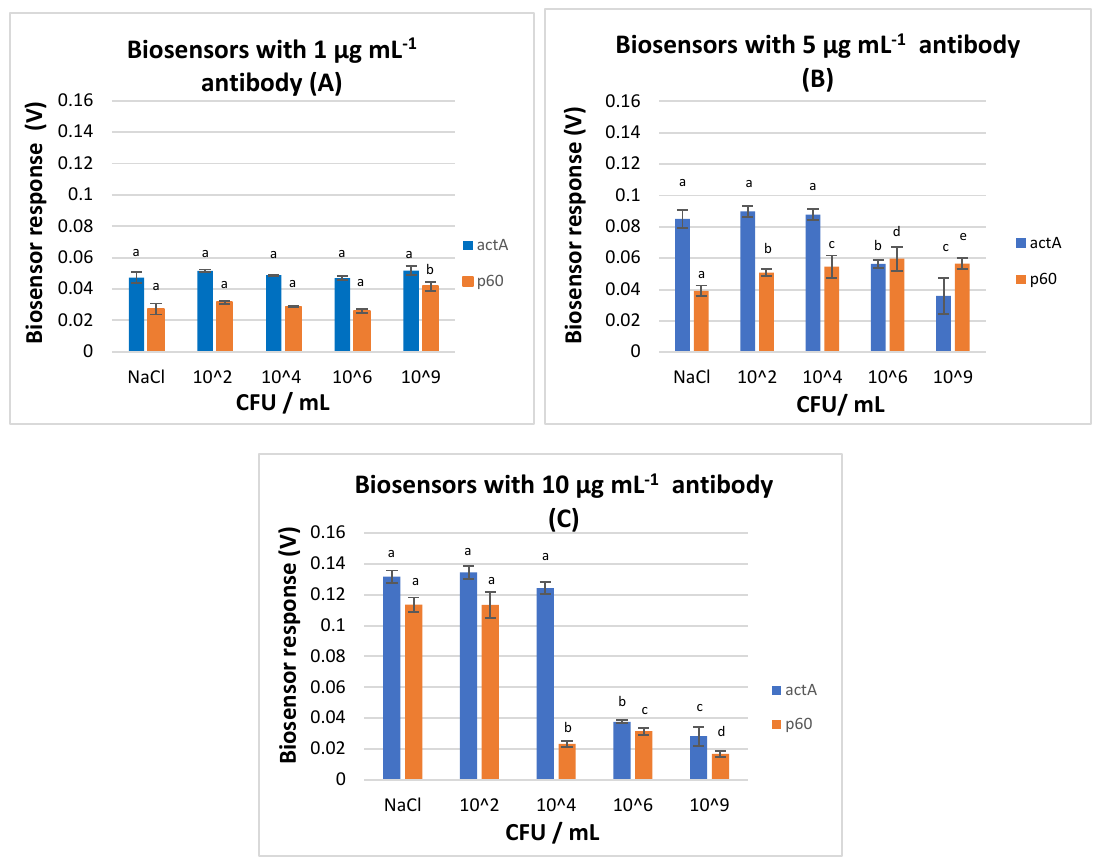
Figure 6. Response of actA and p60-biosensors with ( A ) 1 μg mL −1 , ( B ) 5 μg mL −1 , and ( C ) 10 μg mL −1 antibody concentration in the absence (NaCl 0.85%) and presence of L. monocytogenes at 4 different final concentrations (2, 4, 6, and 9 log CFU mL −1 ). Error bars represent the standard errors of the mean value of all replications. Columns marked with different letters indicate that response was significantly ( p < 0.05) different from the respective of the blank samples (NaCl) for each experimental assay.